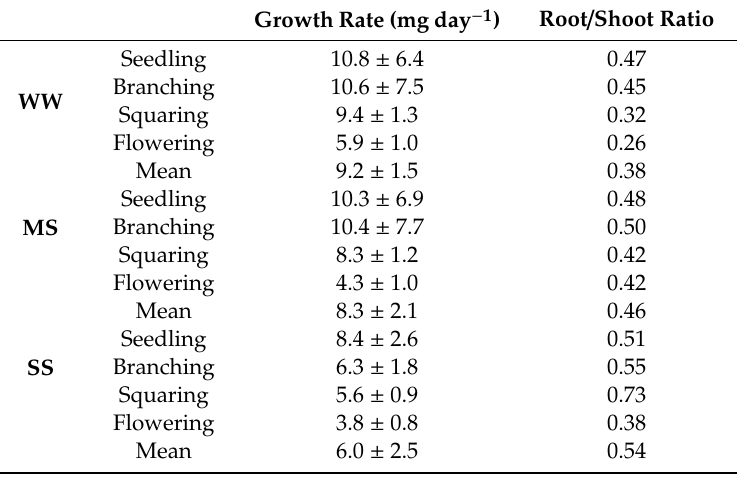
Table 1. E ff ect of three watering treatments (WW: water-su ffi cient (85% PC), MS: moderate water stress (65% PC), and SS: severe water stress (45% PC)) on the growth rate and root / shoot ratio of lucerne at di ff erent growth stages: seedling, branching, squaring, and flowering. The mean growth rates and root / shoot ratios for the period from the beginning of the water treatments to flowering are also given. The values are means ± standard error of the mean ( n =